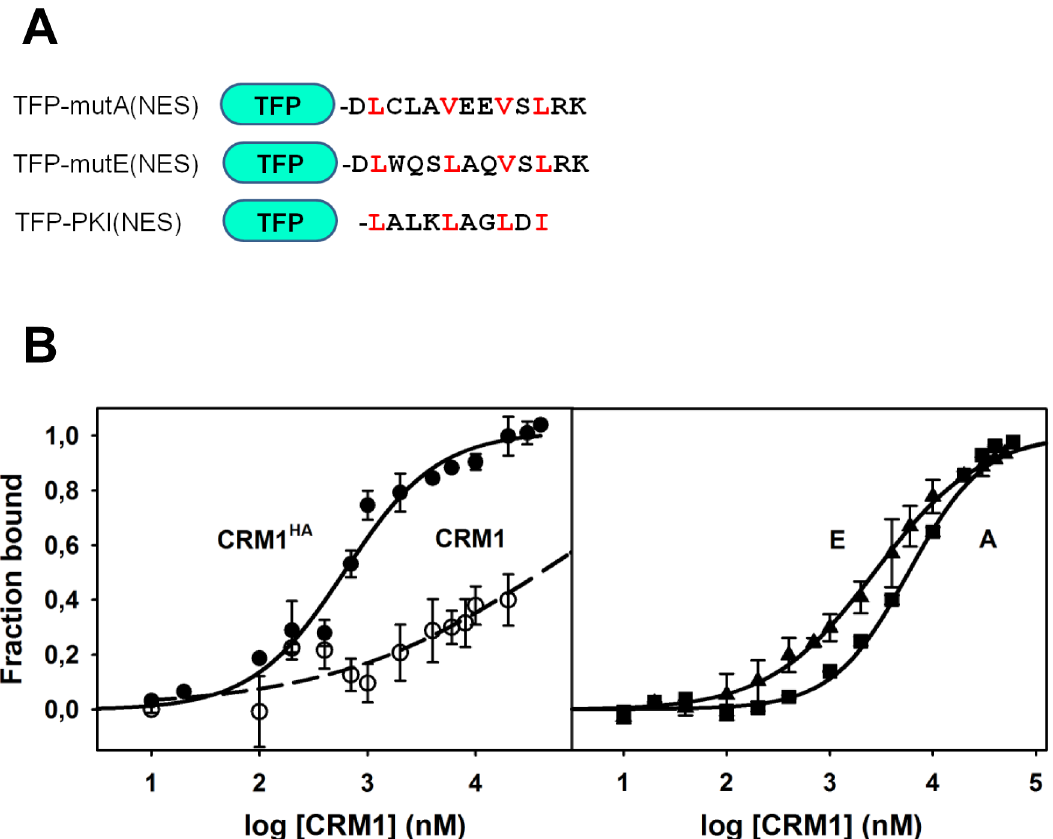
Fig 4. Binding of CRM1 to TFP-NES constructs. (A) Scheme of the engineered TFP constructs, showing the sequence of the NES motifs. Φ residues are highlighted in red. (B) Titration of CRM1 onto the different TFP constructs (50 nM), at 25°C, in buffer 20 mM Tris/HCl, pH 7.4, 50 mM NaCl, 5 mM DTT, 2 mM MgCl 2 : Left panel: Binding of CRM1 HA (solid symbols) or wild type CRM1 (empty symbols) to TFP-PKI(NES). Right panel: Binding of CRM1 HA to TFP-mutE (NES) (triangles) and TFP-mutA(NES) (squares). Fraction bound was calculated from the relative increase in fluorescence anisotropy of TFP ( λ exc 463 nm, λ em 500 nm). Error bars correspond to at least three measurements per CRM1